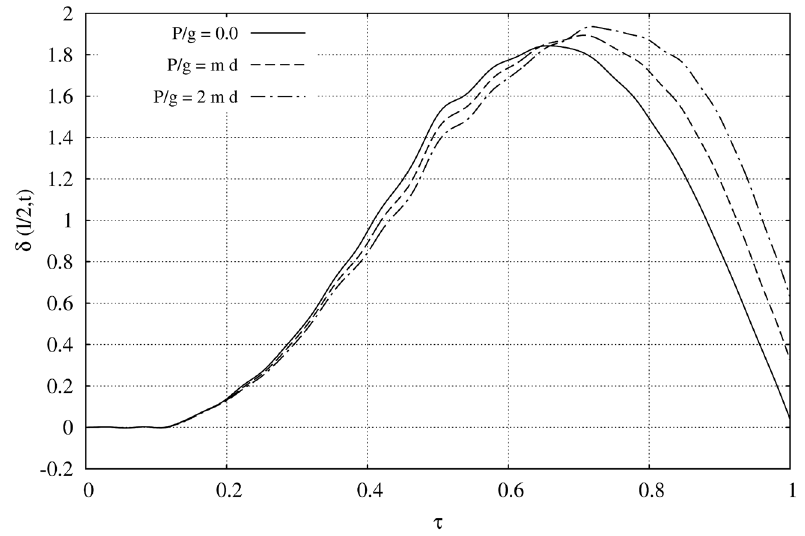
= 10 -5 E , µ = 1 nm, γ = 0.01, m d = 1.621·10 -15 w i